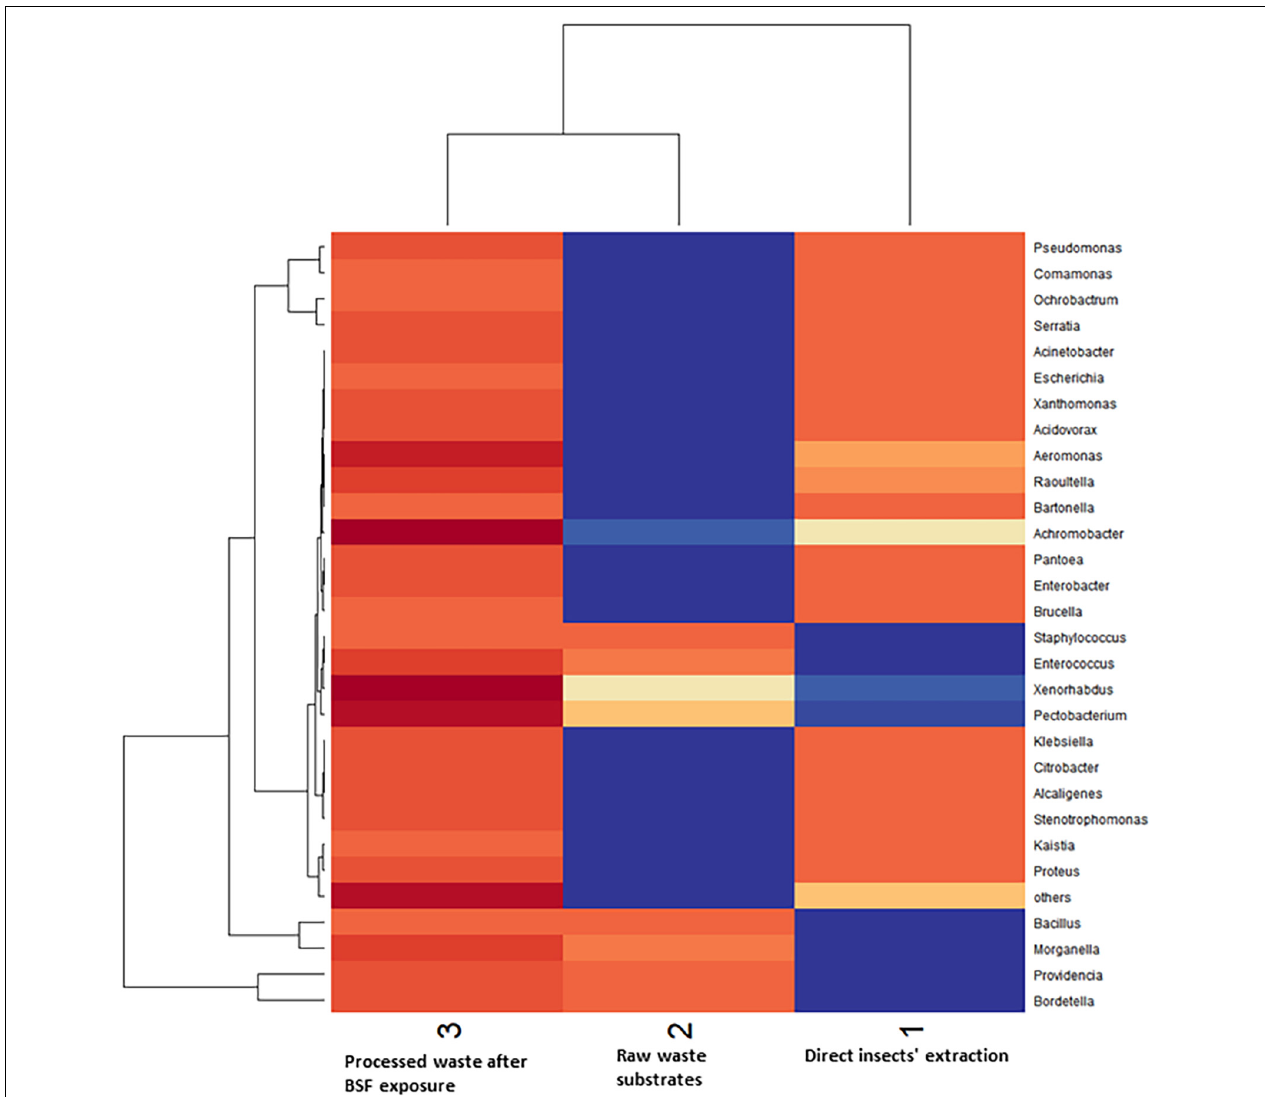
FIGURE 6 | A heatmap depicts the differential abundance of microbial taxa that varied among sample groups at FDR < 0.05. Rows (microbial taxa at genus level) and columns (samples) were ordered by hierarchical clustering. The top dendrogram shows which environmental parameters (samples) have the most similar responses. The side dendrogram shows which genera are behaving most